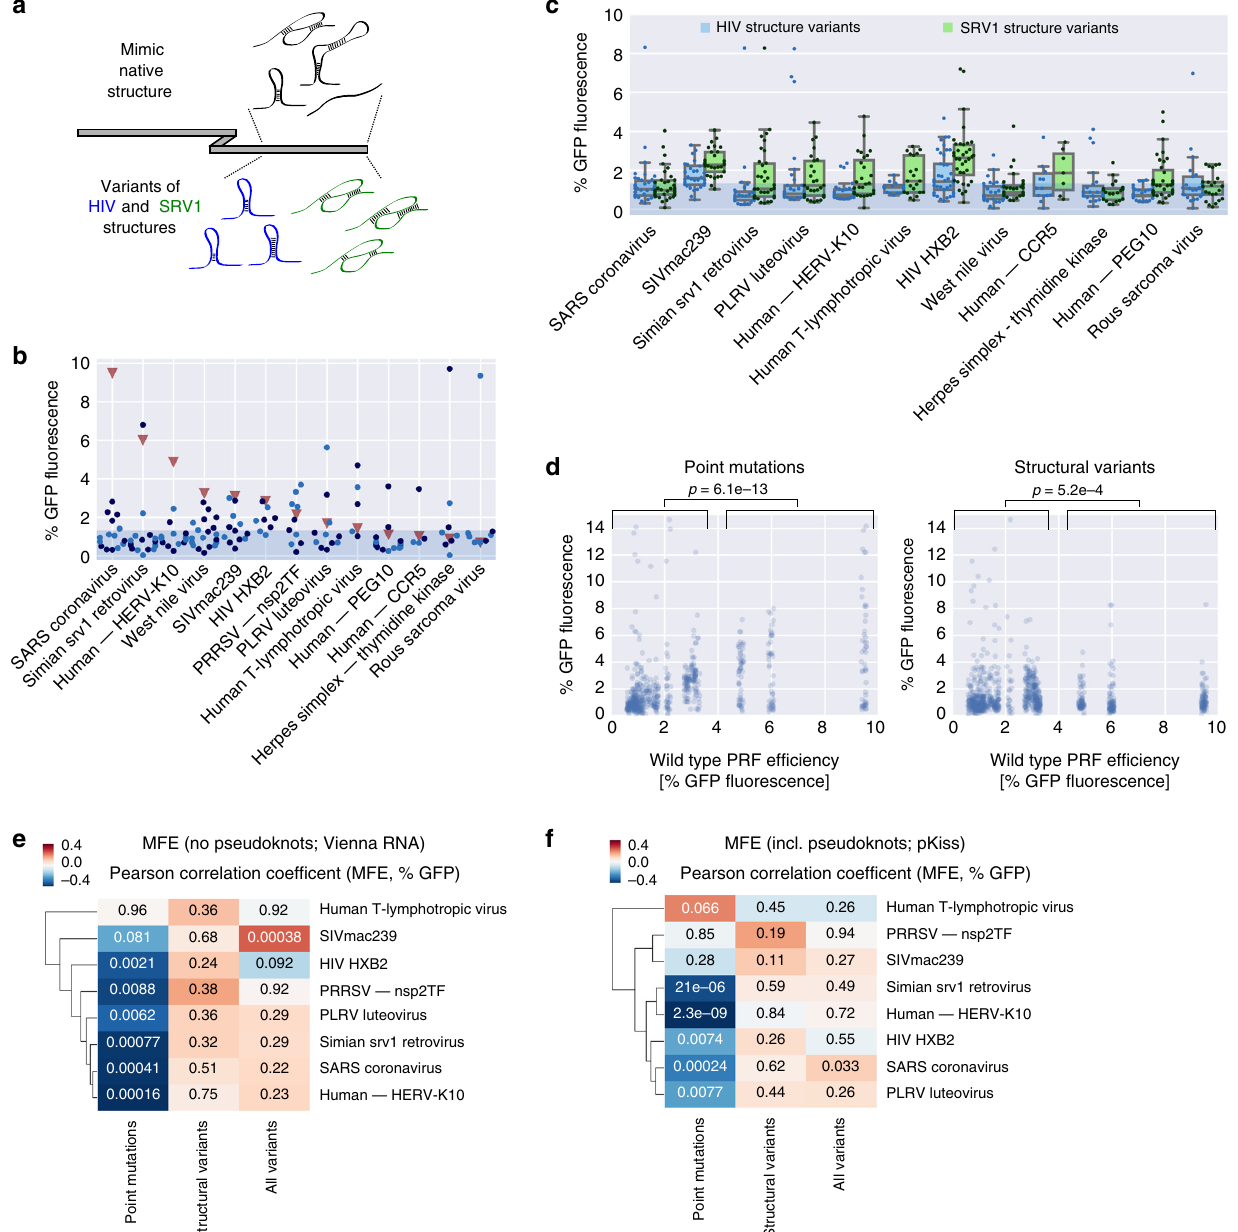
Fig. 4 Downstream RNA structure affects PRF ef fi ciency in a context-dependent manner. a Schematic of downstream structure variations. b Percent − 1 GFP fl uorescence of variants, in which the downstream region is replaced by a synthetic sequence predicted to fold into the respective native secondary structure (using Vienna RNA (only stem-loop; light blue) or pKiss (including pseudoknots; dark blue; Methods section)); the shaded area denotes the range of background fl uorescence; n = 15, 17, 13, 19, 12, 8, 11, 11, 5, 17, 4, 8, and 8 sequences tested, in the order they appear on the graph. c % − 1 GFP fl uorescence of variants, in which the downstream region is replaced by a synthetic sequence predicted to fold into the HIV (blue) or SRV1 (green) secondary structure (or variations thereof; Methods section); the box shows the quartiles of the dataset, while the whiskers show the rest of the distribution except for outliers; the shaded area denotes the range of background fl uorescence; n = 38/37, 32/29, 30/34, 32/29, 32/27, 16/21, 41/36, 34/ 31, 14/7, 23/20, 37/35, and 25/25 sequences tested for HIV and SRV1 structure variants, respectively, in the order they appear on the graph. d % GFP fl uorescence of variants, in which the downstream region carried a single-point mutation (left) or was replaced with sequences predicted to fold into variations of PRF-inducing structures, plotted against the corresponding wild-type values; p -values (Mann – Whitney U ) for comparisons between groups of low (<4% GFP fl uorescence) and high wild-type PRF (>4% GFP fl uorescence). e , f Clustered heat map of Pearson correlation coef fi cients between % − 1 GFP fl uorescence and minimum free energy of regions after the slippery site (computed using Vienna RNAfold on the 40 nt following the slippery site ( e ) or pKiss on the 120 nt following the slippery site ( f )) for groups of variants of the indicated PRF sites; values denote the p -values of the